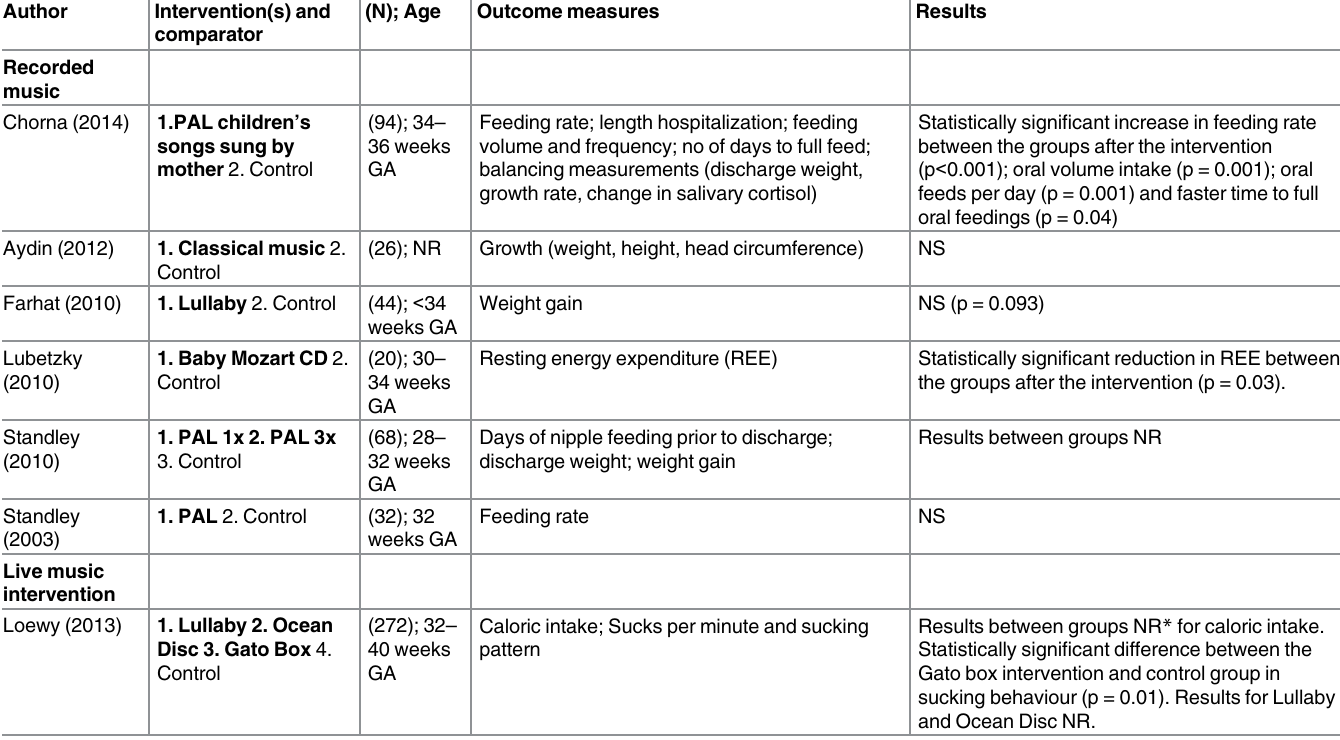
Table 4. Results of the effects of music on growth and feeding outcomes . Results of the effects of music on growth and feeding outcomes compared between the intervention and control groups. Tabulated results compare the experimental intervention in boldface to the control